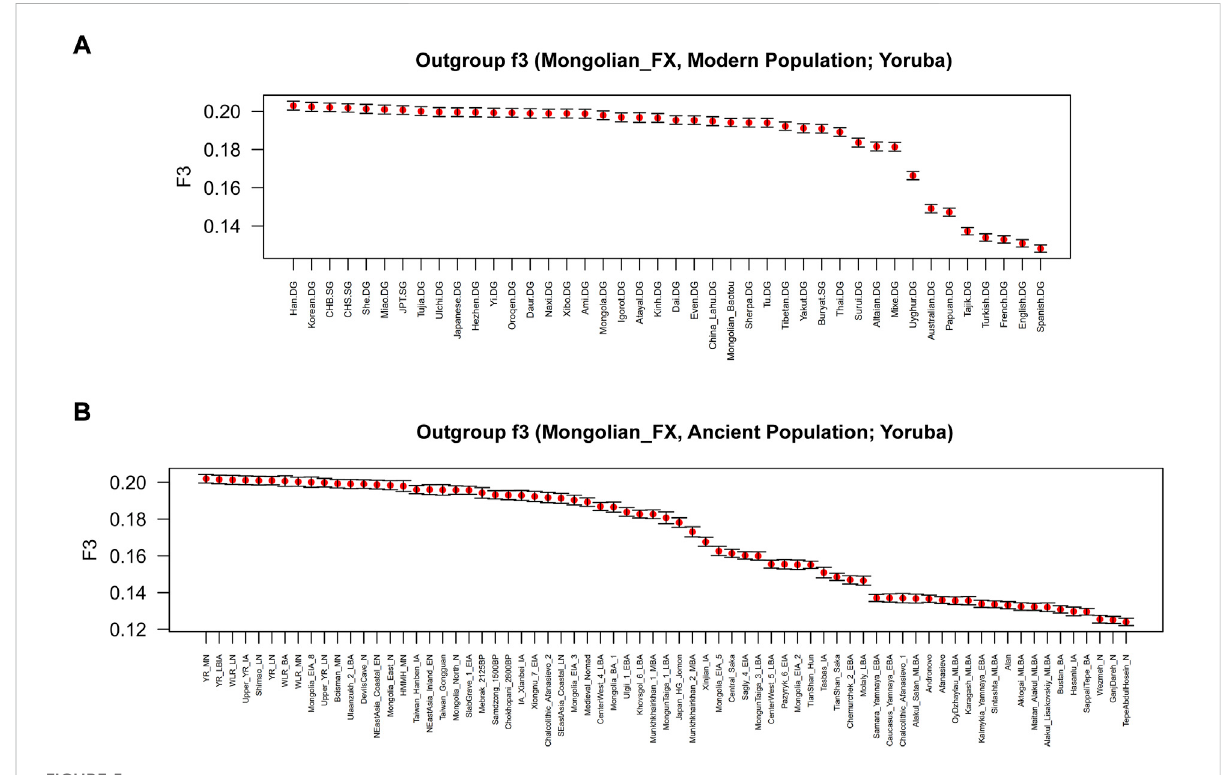
FIGURE 5 Shared genetic drift estimated via f 3 -statistics of the form f 3 (Mongolian_Fuxin, Y; Yoruba) based on the merged 1240K dataset. (A) outgroup- f 3 (Mongolian_Fuxin, Modern population; Yoruba). (B) outgroup- f 3 (Mongolian_Fuxin, Ancient population; Yoruba).